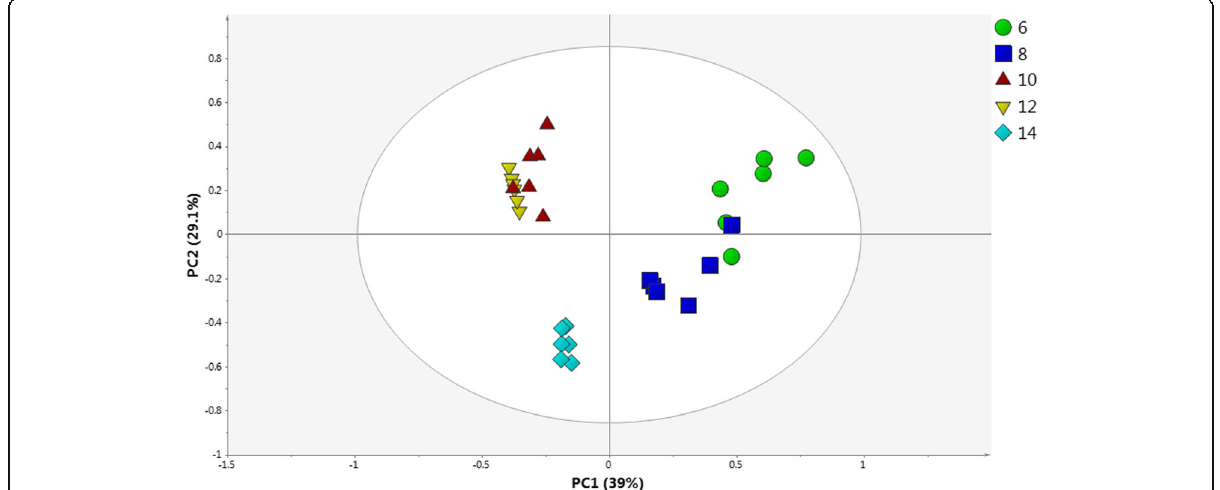
Fig. 5 PCA score plot of the 1 H NMR data of different harvesting ages of C. caudatus